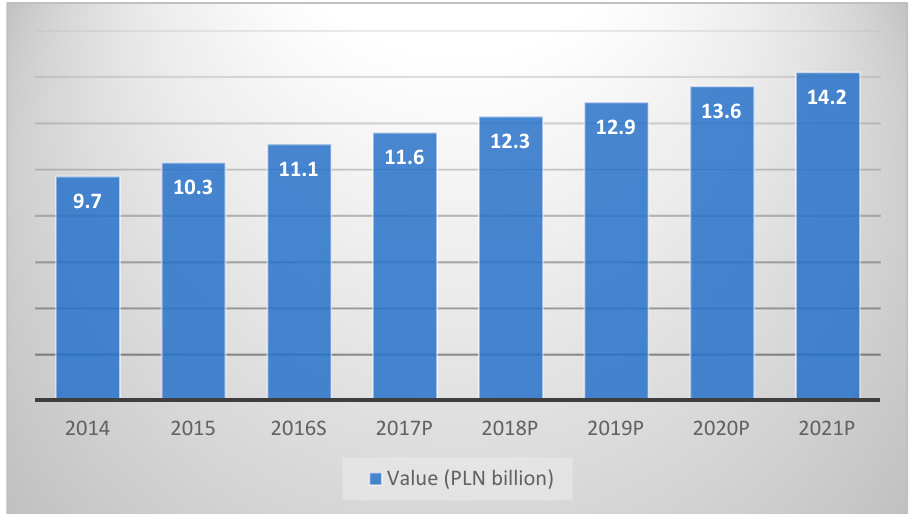
Figure 3. Value of the OTC market in Poland, 2014–2021. P—prognosis, S—estimation. Source: own study based on [35].